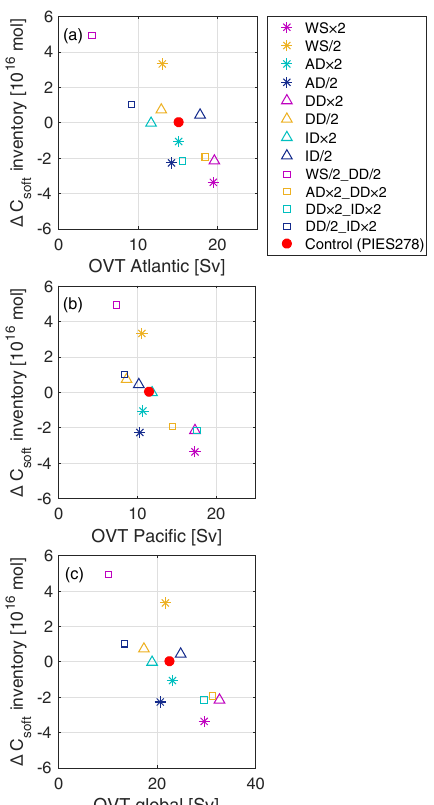
Figure 4. Strength of the overturning circulation in terms of OVT (see Section 3.4) and the change in C soft inventory ( M o · (cid:49)C soft ) for equilibrium states SE1–SE12 relative to the control PIES278 (red dot). This is shown for the Atlantic basin, Pacific basin and for the global measure based on hemispheric differences on the horizontal axis of panels (a, b, c)